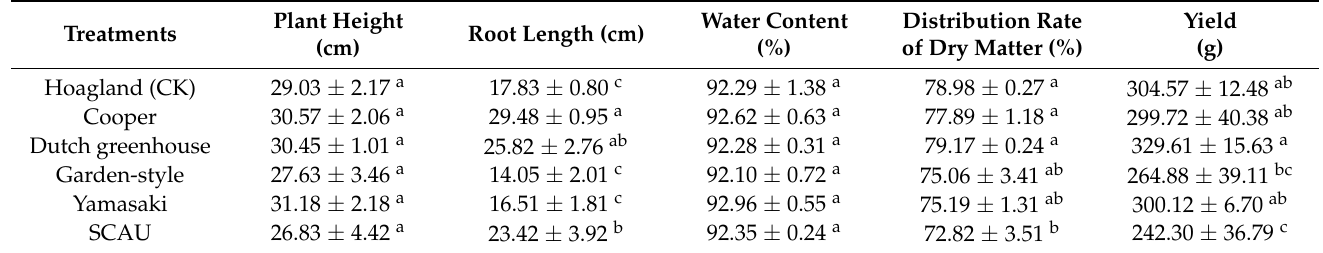
Table 1. The effects of nutrient solution culture with different formulations on the growth characteris- tics of water